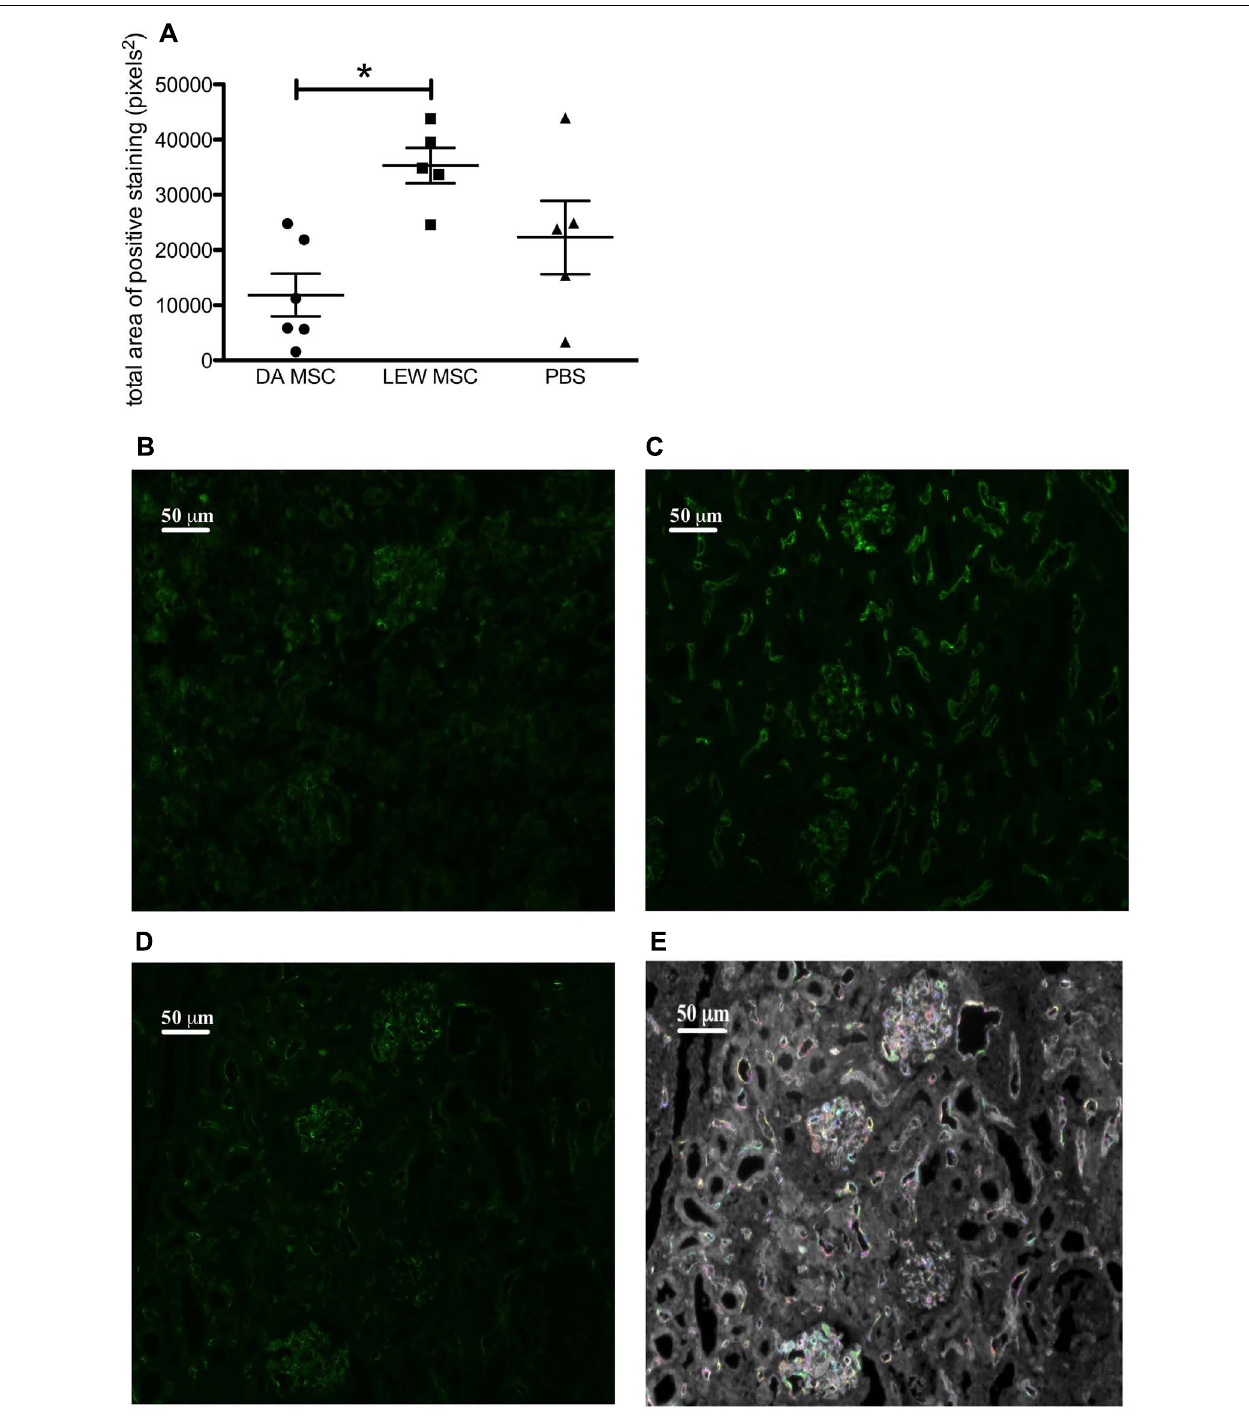
FIGURE 6 |Amplified C4d deposits in transplanted kidneys following MSC pre-treatment. Immunofluorescence labeling was performed on sections prepared from transplanted kidneys using a polyclonal antibody to rat C4d incubated overnight followed by detection with an Alexa Fluor ® 488 donkey anti-rabbit IgG (H + L) secondary antibody. (A) Images obtained by fluorescence microscopy were evaluated using the Columbus TM Image Data Storage and Analysis System to quantify C4d (green fluorescence) labeling.